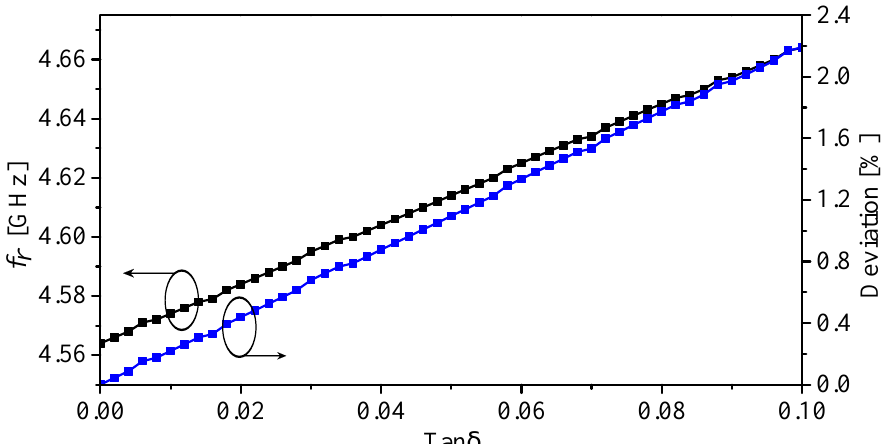
Figure 10. The resonance frequency and the deviation in the resonance frequency with respect to the resonance frequency in the case of the loss tangent of 0 versus the loss tangent, in the presence of (cid:101) r =